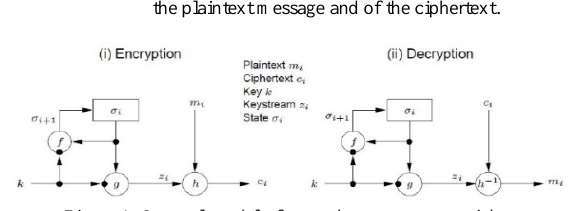
Figure 1: General model of a synchronous stream cipher